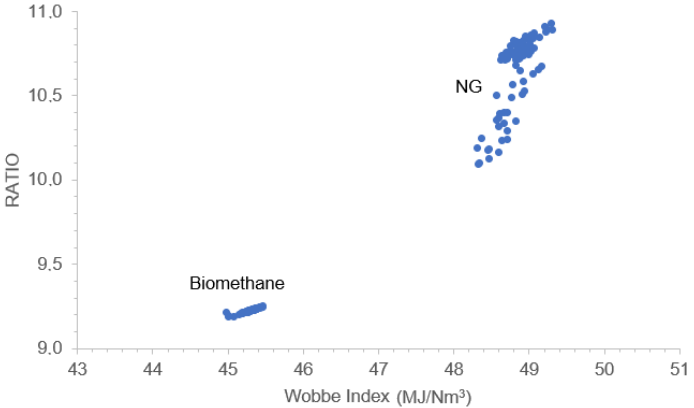
Figure 2. RATIO variation with WI for NG and biomethane. Table 1. Volume compositions of average NG, average biomethane and MIX (X = 0.698).